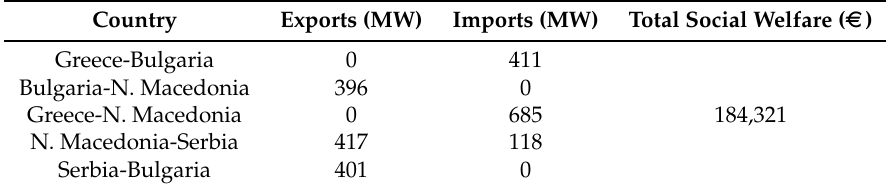
Table 4. Cross-border flows via the ATC method for the 4 country scenario.